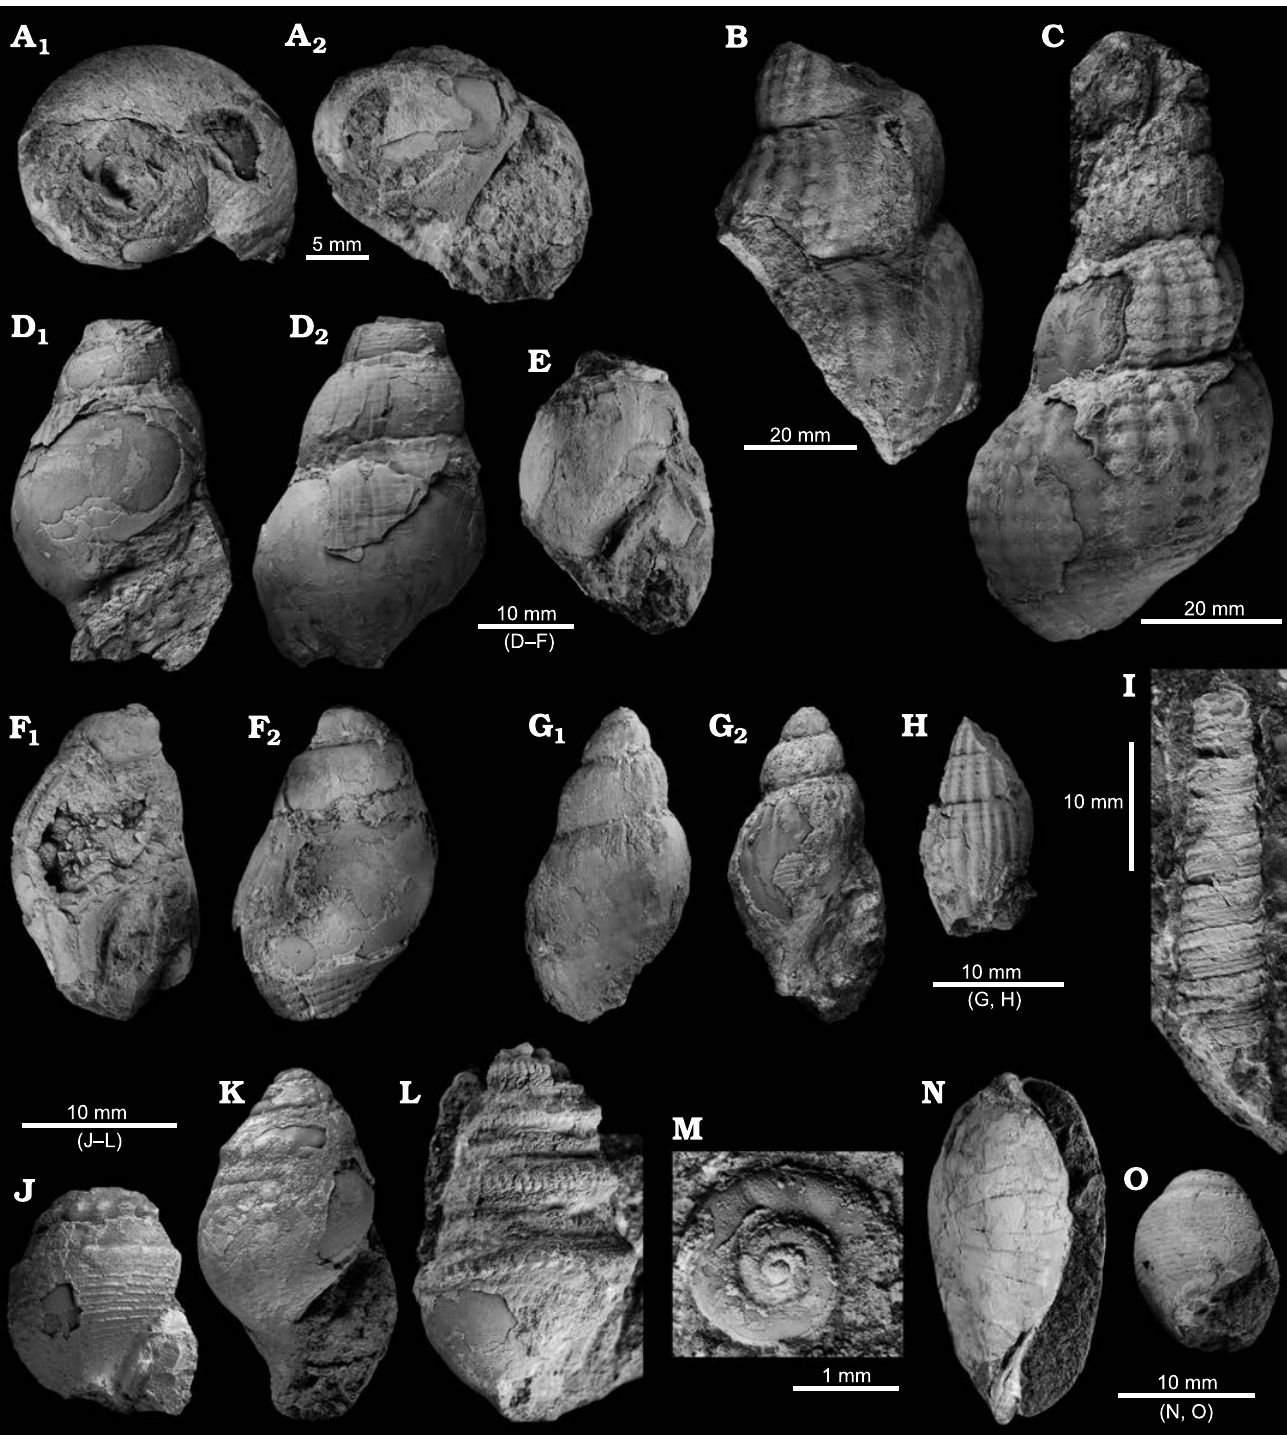
Fig. 20. Caenogastropoda and Opisthobranchia from Upper Miocene seep deposits of the Amlang Formation in Pangasinan province, Luzon, Philippines. A . Naticidae gen. et sp. indet., NRM Mo 192628, imperfect specimen in apical and apertural views. B , C . Very large Fusinus ? sp., imperfect